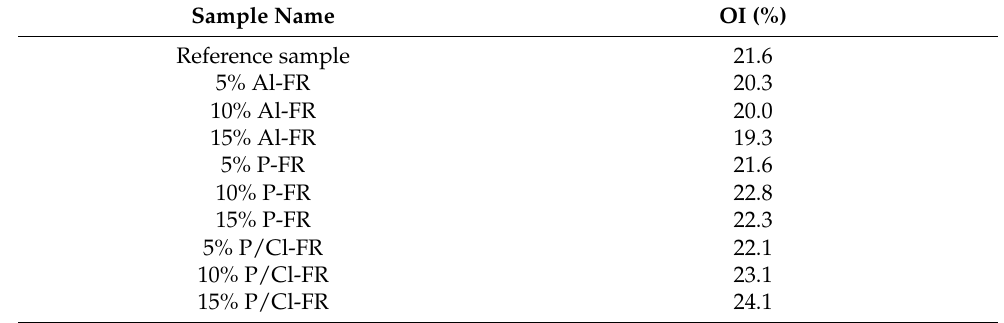
Table 2. Limiting oxygen index